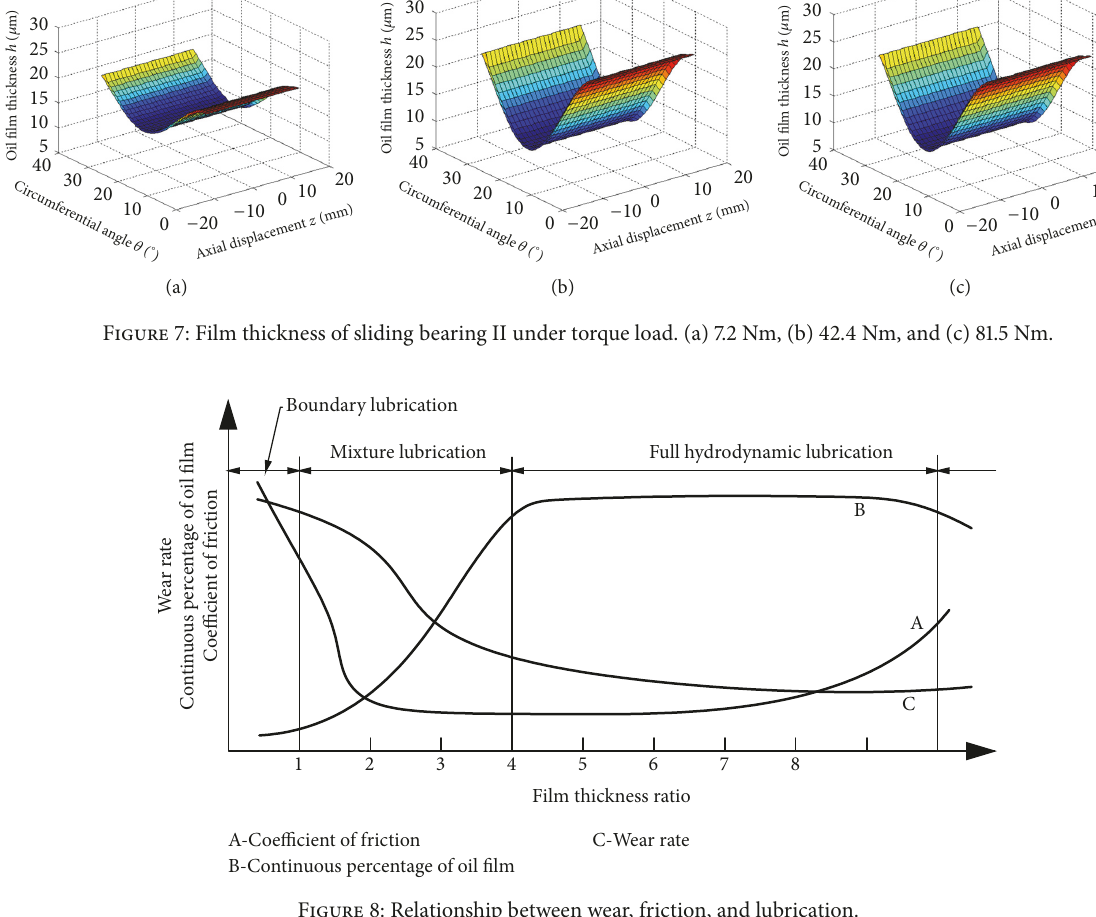
Figure 8: Relationship between wear, friction, and lubrication.